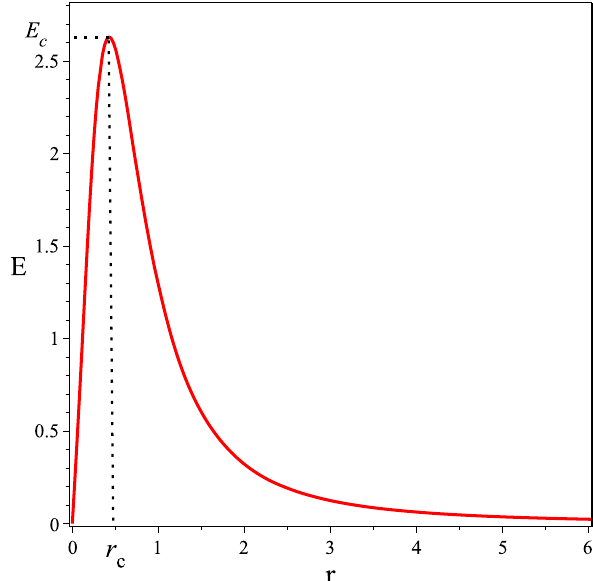
Fig. 2 The behavior of the electric field in terms of r for M = 1 , Q = 0 .